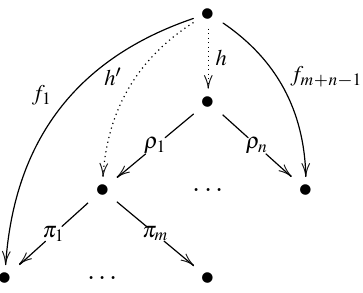
Figure 1. Construction of universal